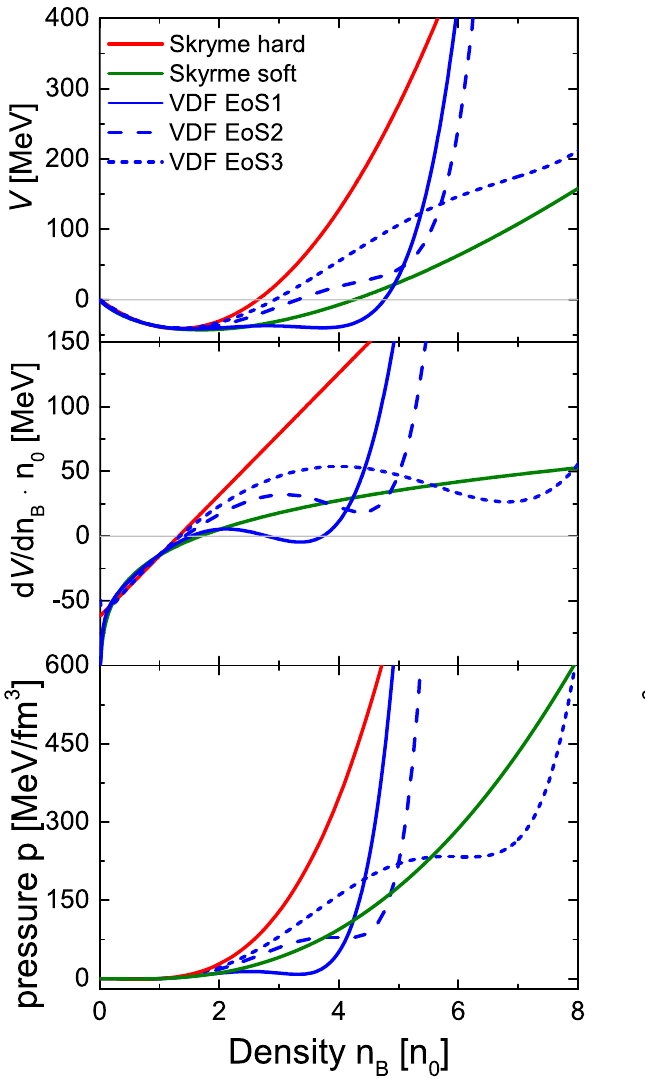
Fig. 1 Upperplot:FieldenergyperbaryonofthreeversionsoftheVDF EoScomparedtothosefromthehardandsoftSkyrmeparametrizations. Middle plot: derivative of the field energy per baryon with respect to the baryon density, entering the calculation of the MD-forces, for the same EoSs. All VDF EoSs incorporate a phase transition (see Table 1) and show significant unstable regions at different densities. Lower plot: pressure as function of the baryon density for all VDF EoSs, compared to the hard and soft Skyrme models